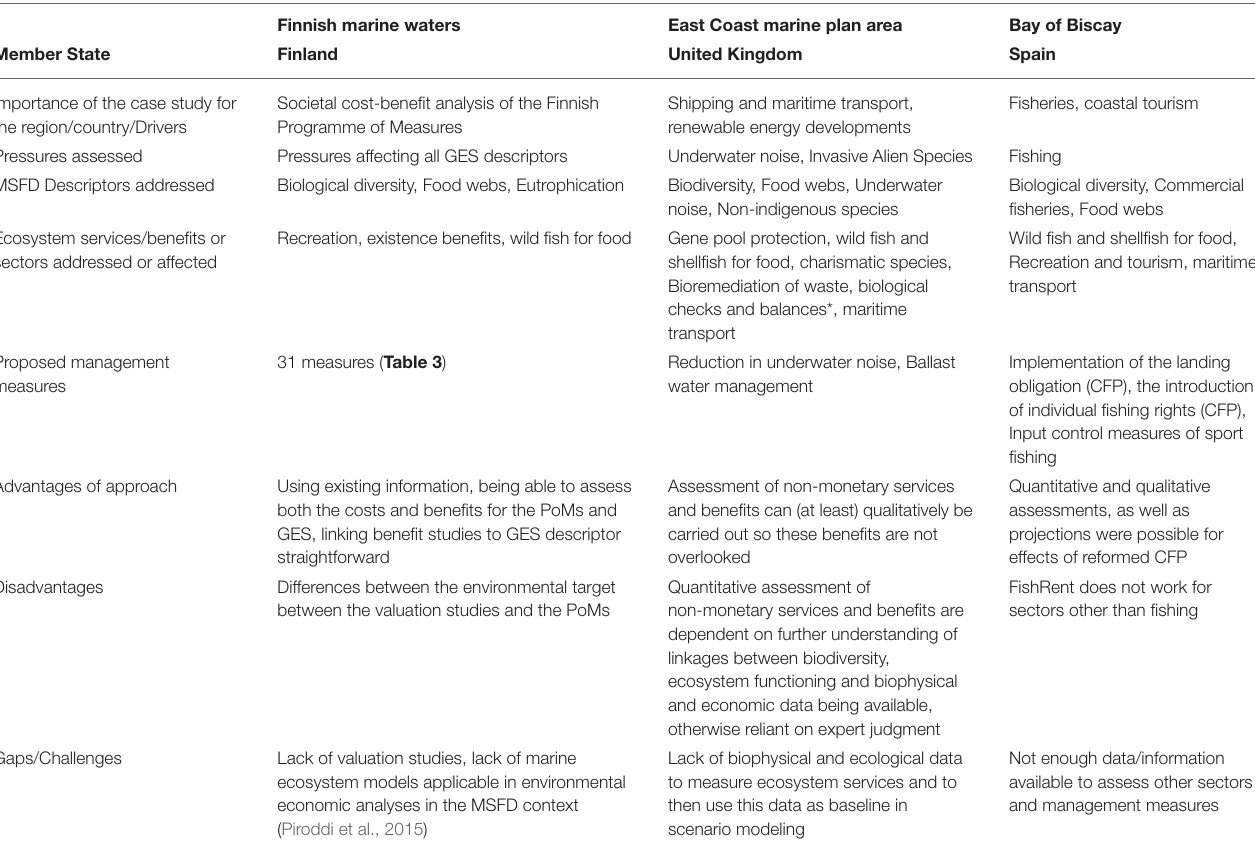
TABLE 8 | Main findings from the three case